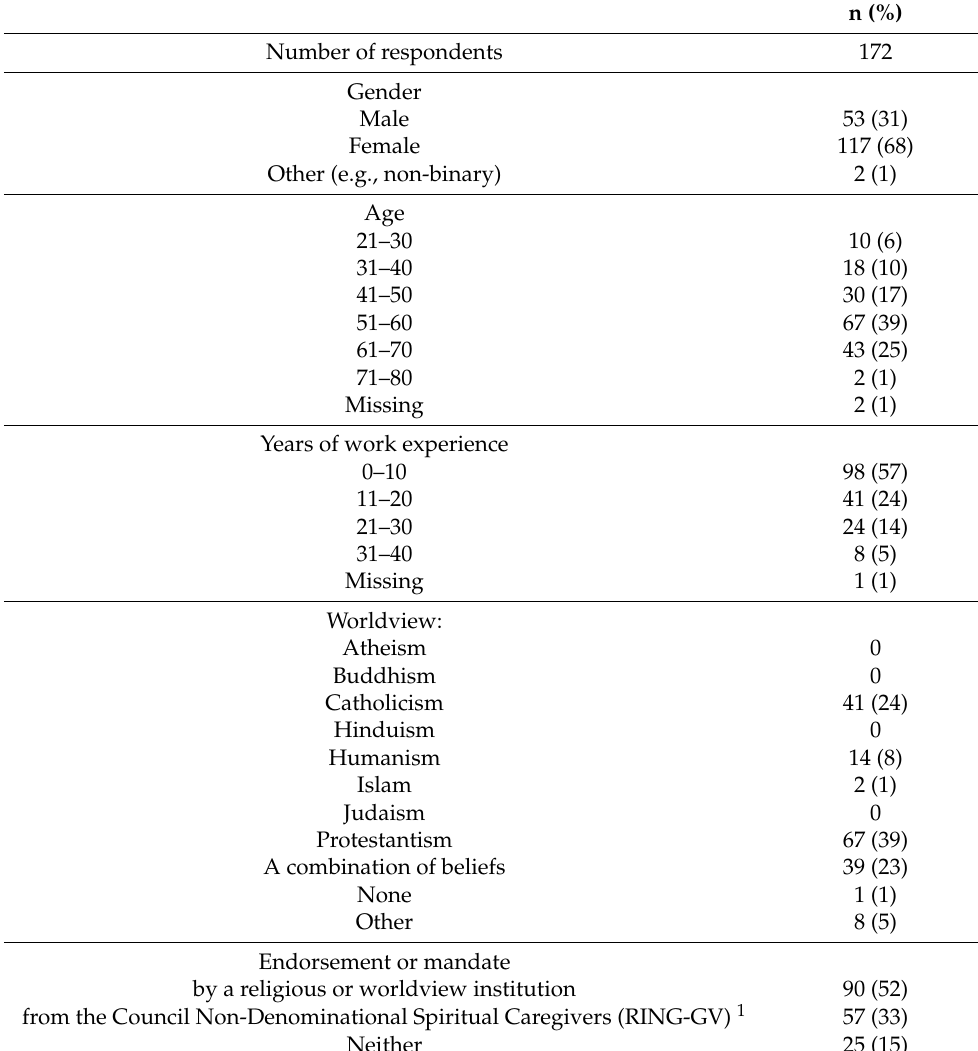
Table 1. Characteristics of